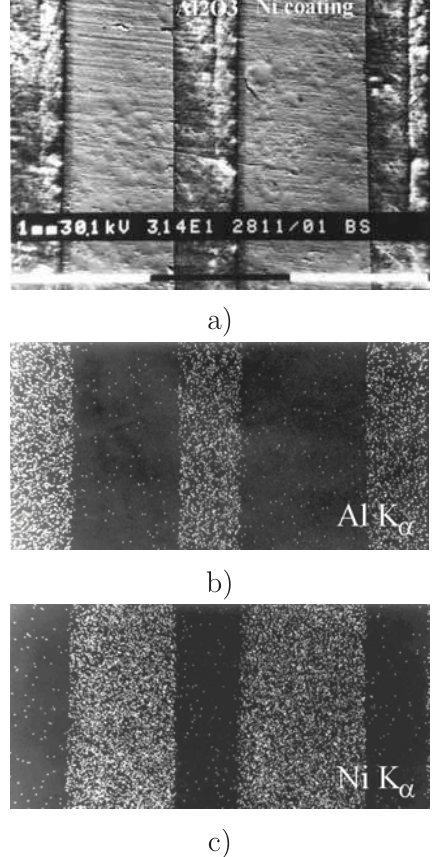
Fig. 3 SEM micrographs of microstructured under Nd:YAG laser exposure Ag/Al 2 O 3 /Al system at energy density 0.5 J/cm 2 and 50 pulses (a), and corresponding X-ray maps for Al (b) and Ni